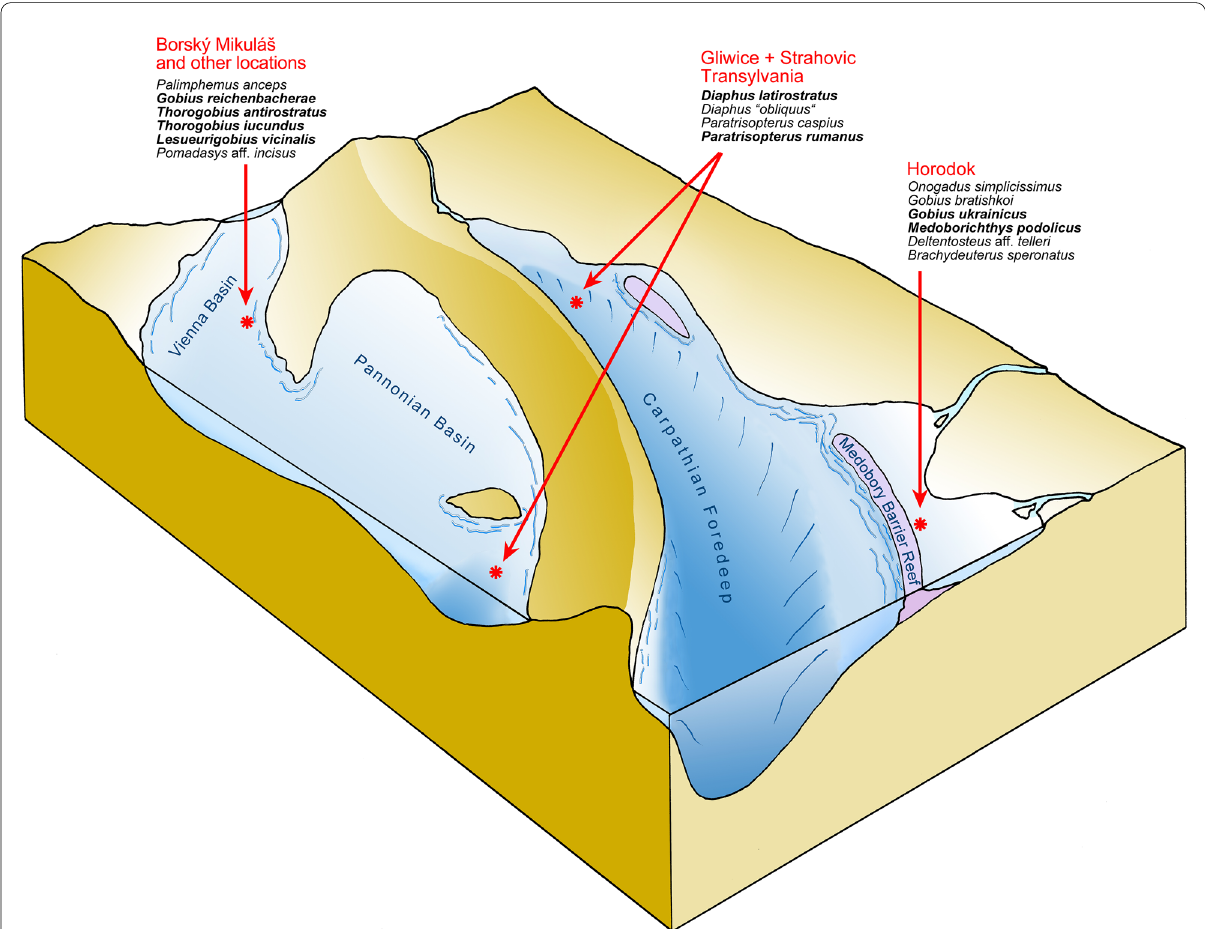
Fig. 11 Schematic block diagram of the northern part of the Central Paratethys during the late Badenian depicting the main localities from which otolith have been studied and the common species found therein (most common ones shown in bold printing). Diagram not to scale and not proportional; based on Kováč et. al.